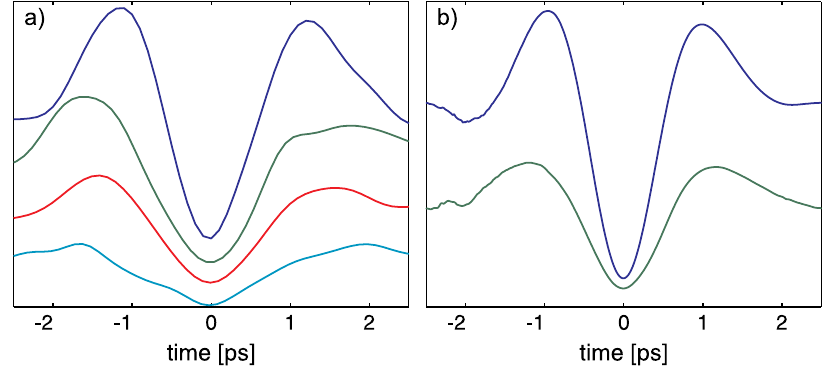
FIG. 14. (a) EOS measurements from turn 0 to turn 3. (b) Arrival time jitter corrected average of 500 EOSD measurements for turn 0 and turn 1. The curves are shifted vertically for better visibility.